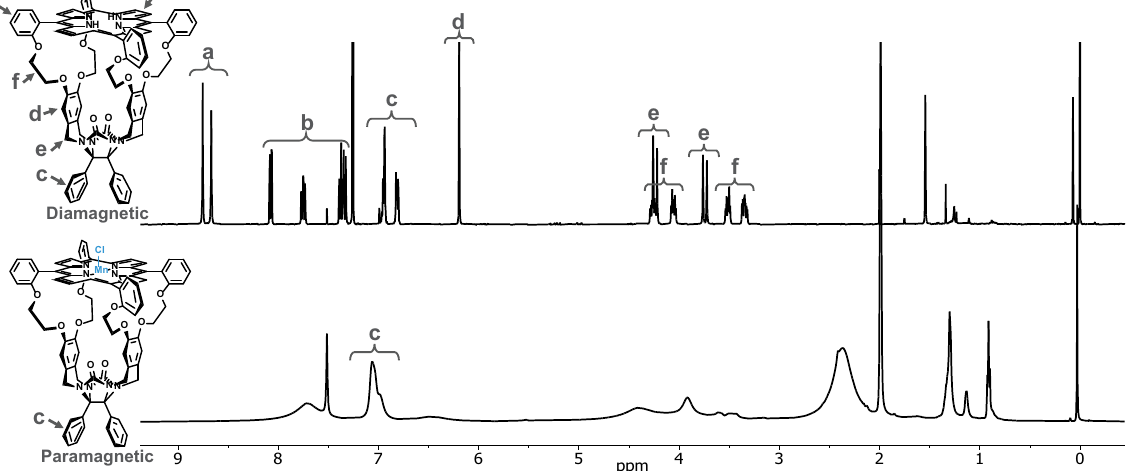
Fig. 2 In fl uence of the presence of a paramagnetic Mn center on the 1 H NMR spectrum of a host compound. Top: 1 H NMR spectrum of metal-free porphyrin cage compound H 2 1 (500 MHz, chloroform- d : acetonitrile- d 3 , 1:1 (v/v), 25 °C), bottom: 1 H NMR spectrum of Mn1 (500 MHz, chloroform- d :